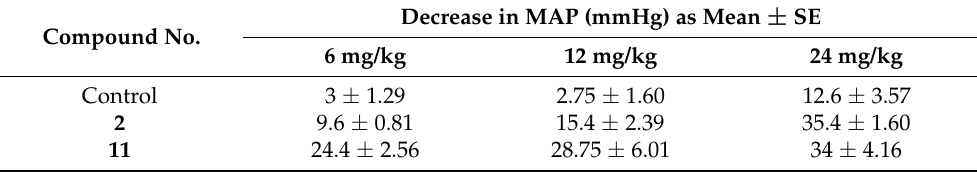
Table 4. Hypotensive activity of selected test compounds (mg/kg, i.v.) in normotensive anesthetized dogs represented by change in MAP (mmHg) as mean ± SE ( n = 3–5) a . Compound No.